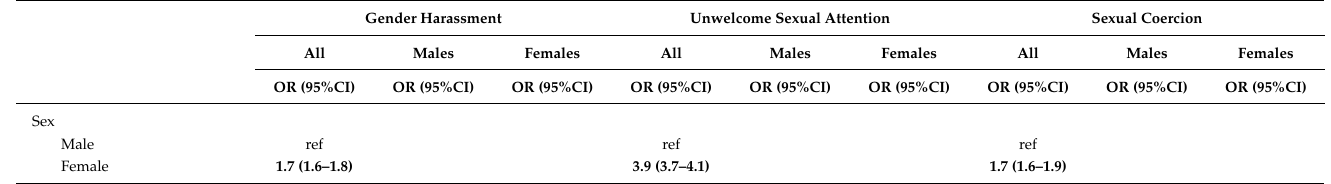
Table 3. Multivariate associations between gender and sexuality related variables and experiences of subjection to three forms of sexual harassment among 14–16-year-old Finnish